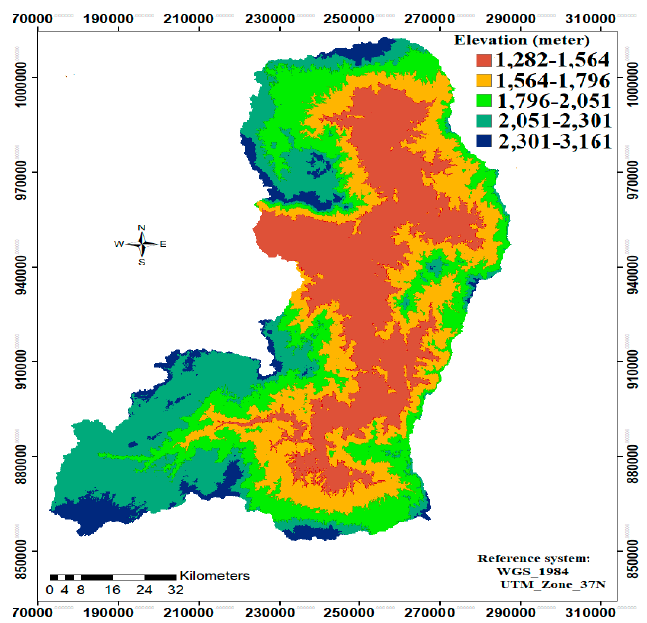
Figure 2. Digital elevation model of the Didessa river basin.